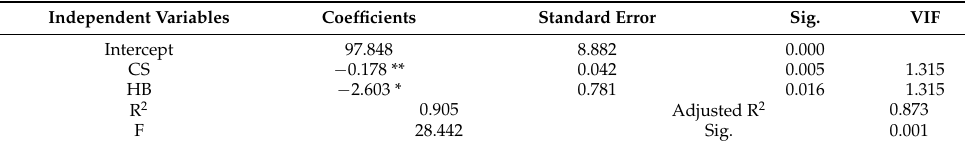
Table 4. Summary of multiple linear regression (MLR) model results for estimating YLD